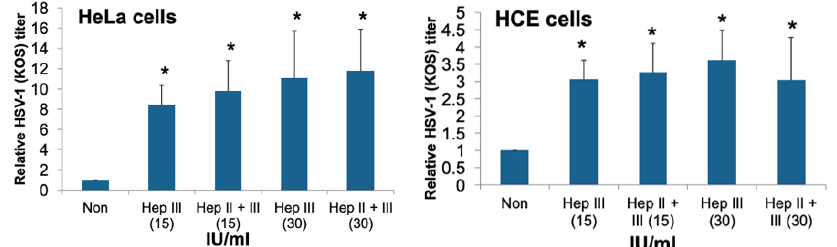
Figure 3. Recombinant heparinases treatment to HSV-1 infected HeLa and HCE cells induces HSV-1 release from infected cells. HeLa and HCE cells were infected at an MOI of 1 with HSV-1 (KOS) for 2 h. After 2 h, cells were treated with citrate buffer (pH = 3) for 1 min, which was followed by cell washing. Then, cells were either mock treated or treated with heparanase III or a combination of heparanase II and III, at 15 or 30 IU/mL for 2 h at 37 °C. After 2 h, cells were washed, and growth medium was added back to the cells. HSV-1 release from infected cells was examined after 20 h incubation at 37 °C post cell treatment by plaque assay using Vero cells. Results are means ± 1 SD of three independent experiments conducted in duplicate (* p < 0.05).